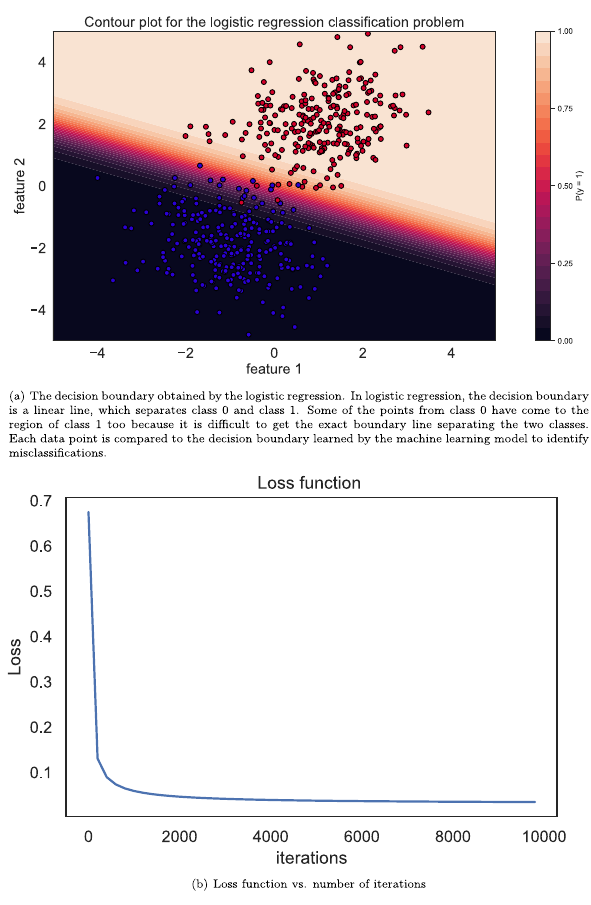
Figure 6. The results of the logistic regression for this binary classification problem. As can be found most of the points are correctly classified, i.e., only 7 out of 500 points corresponding to the test dataset are misclassified. The loss function demonstrates that the convergence may be achieved after 2000